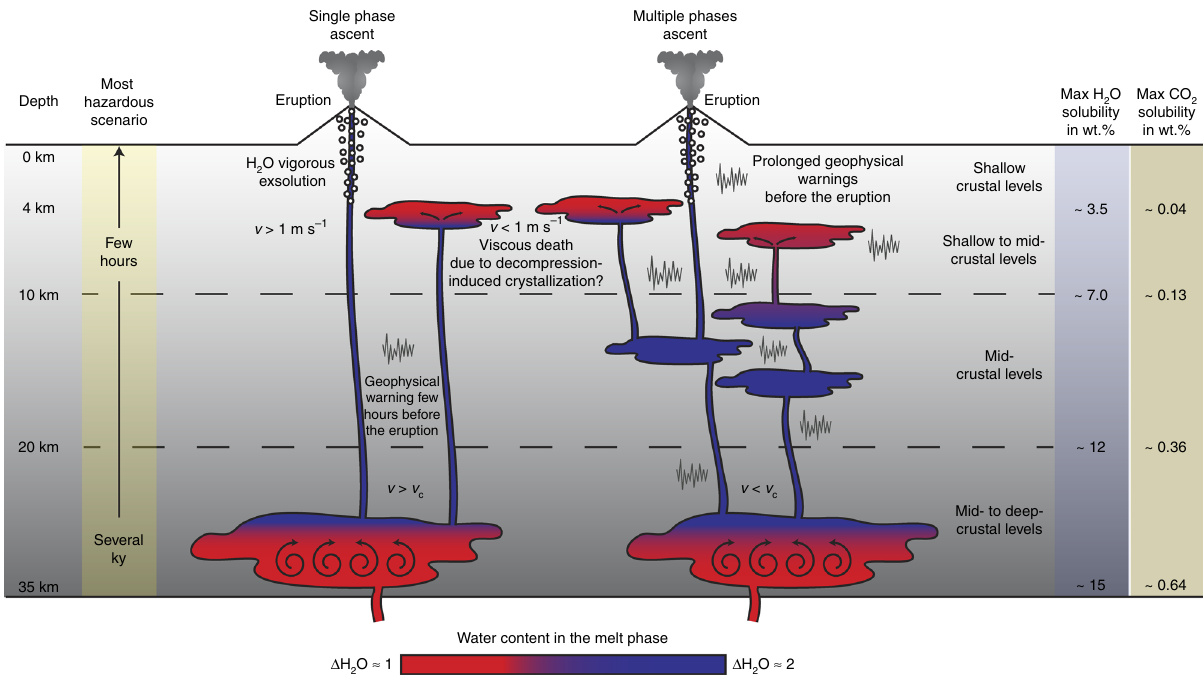
Fig. 7 Storage timescales and melt rising velocities. Idealized continental crust section reporting the potential storage times at mid- to deep-crustal levels and the estimated timescales for the rising of a hydrous residual melt. Maximum water and carbon dioxide solubilities are calculated on the residual melt at 1010 °C of the mid-MgO experiments 30 in accordance with the model reported by Ghiorso and Gualda 58 . The multiple phases ascent scenario (right portion) is in agreement with literature data (e.g., Annen et al. 41,55 ). The single phase ascent scenario is reported on the left portion of the diagram. Here, the most hazardous scenario, with geophysical evidences of volcanic unrest occurring a few hours before the eruption is also shown